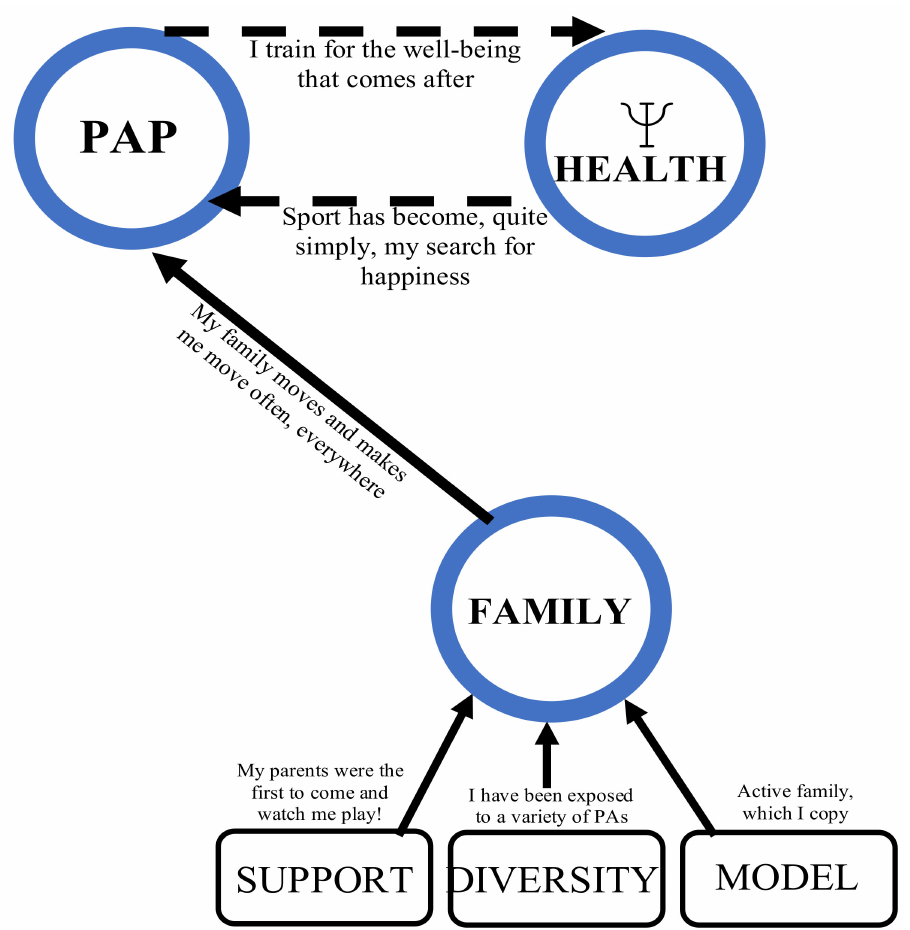
Figure 1. The three most important winning conditions for the adoption and maintenance of healthy lifestyle habits among participants in both profiles (the symbol below health in Figure 1 means Physical activity practice, family and mental health, the same as